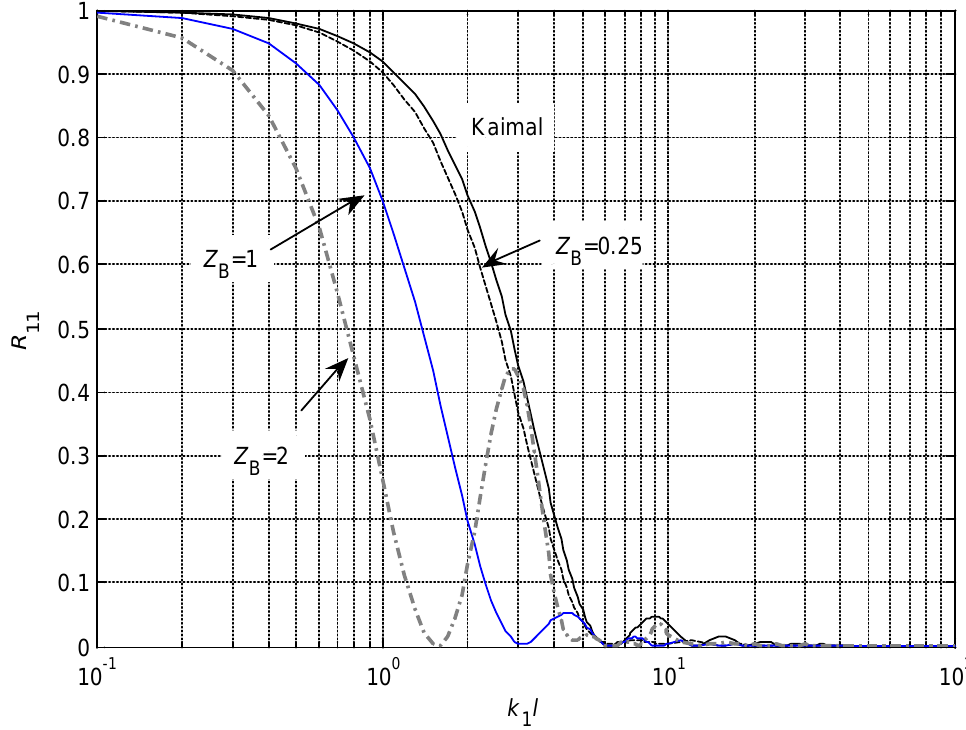
= 0.1 except for the Kaimal ∞